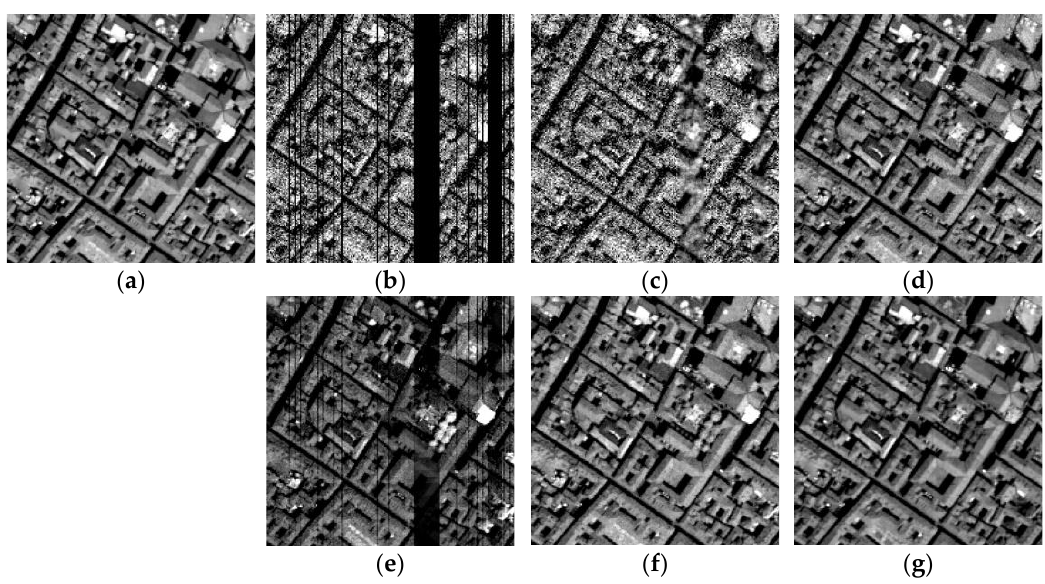
Figure 1. 3D-cube of Pavia Centre hyperspectral data set.